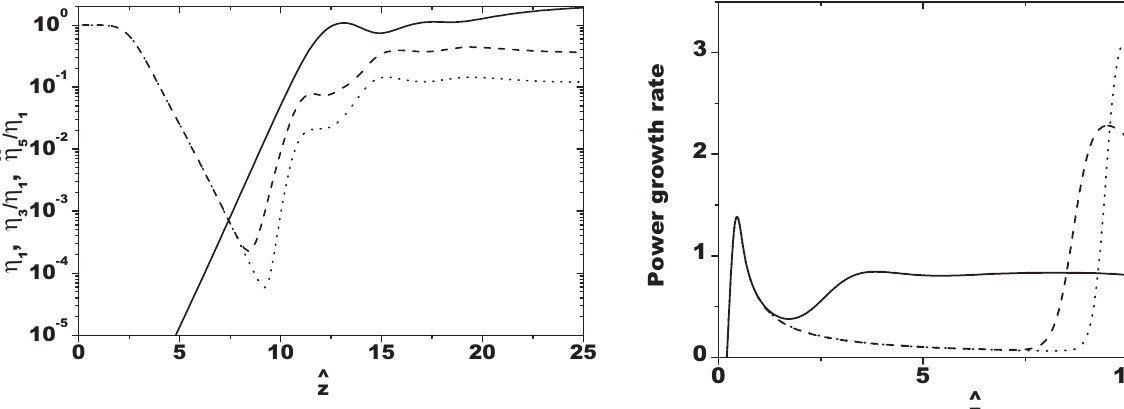
FIG. 2. Normalized averaged power of a fundamental har- monic of SASE FEL, ^ (cid:5) normalized undulator length (solid line). Dashed and dotted lines show a normalized power ratio ^ (cid:5) for the 3rd and 5th